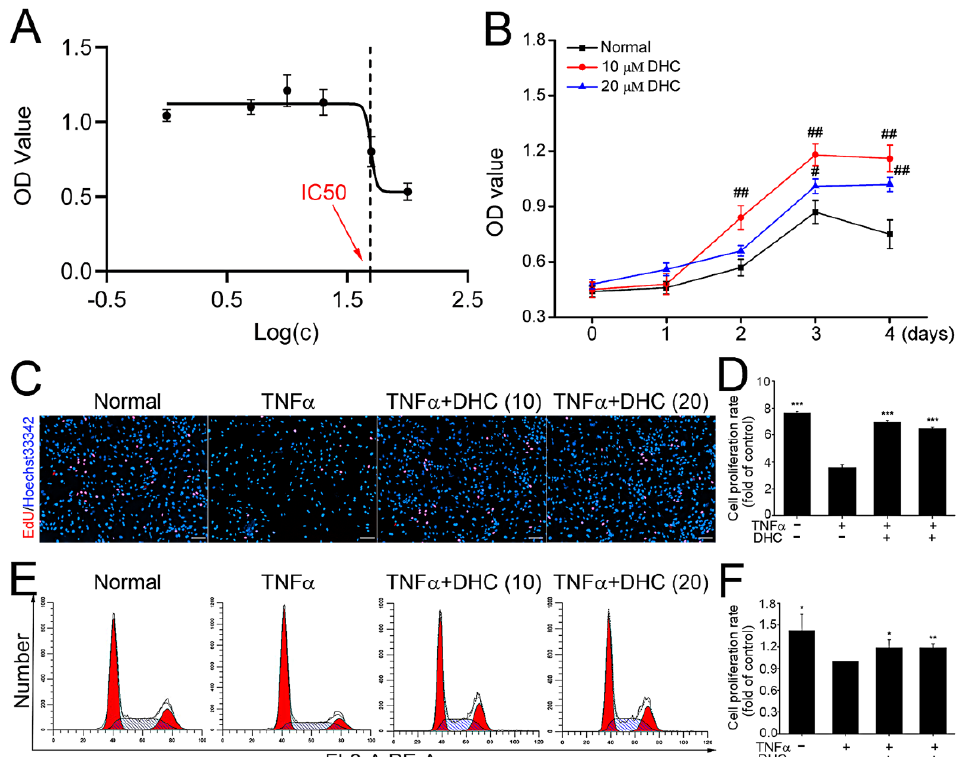
Figure 1. Dehydrocorydaline (DHC) ameliorated cell proliferative capacity of the TNF α -treated human chondrocytes. ( A ) 50% inhibiting concentration (IC50) of DHC on the normal human chondrocytes after culture for 48 h. ( B ) Effects of 10 and 20 μ M DHC on cell activities of normal human chondrocytes after culture for 1, 2, 3, and 4 days. ( C ) EdU-positive cells in the normal, TNF α , TNF α + 10 μ M DHC, and TNF α + 20 μ M DHC groups and ( D ) the quantitative results after treatment for 48 h. ( E ) Cell proliferation of the human chondrocytes in the normal, TNF α , TNF α + 10 μ M DHC, and TNF α + 20 μ M DHC groups detected by flow cytometry analysis and ( F ) the quantitative results after treatment for 48 h. Scar bar = 100 μ m. Data are presented as mean ± SD. *, p < 0.05; **, p < 0.01; ***, p < 0.001 compared to the control group (the TNF α group). #, p < 0.05; ##, p < 0.01 compared to the normal group at the same time point.